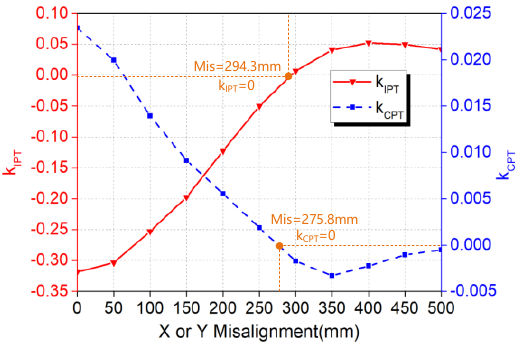
Figure 10. The variation of k IPT and k CPT at X or Y misalignment conditions.